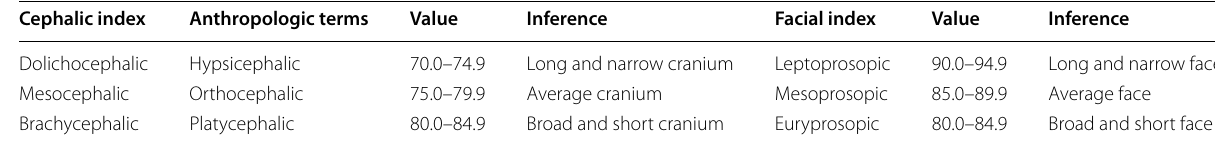
Table 5 Types of cephalic and facial index with inference (Wilkinson 2010; Franco et al.